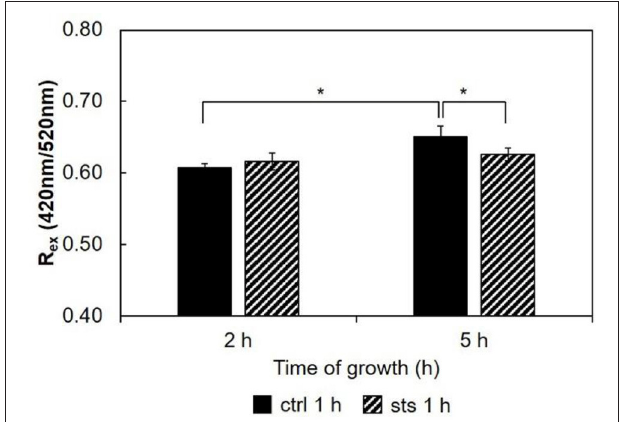
FIGURE 7 | Ratio of di-4-ANEPPS fluorescence intensity produced by excitation at 420nm to that produced by excitation at 520nm, R ex (420 nm/520nm) cells, at 30 ◦ C. The results present the mean ± S.D. of at least three independent experiments, n ≥ 3. * p < 0.05.